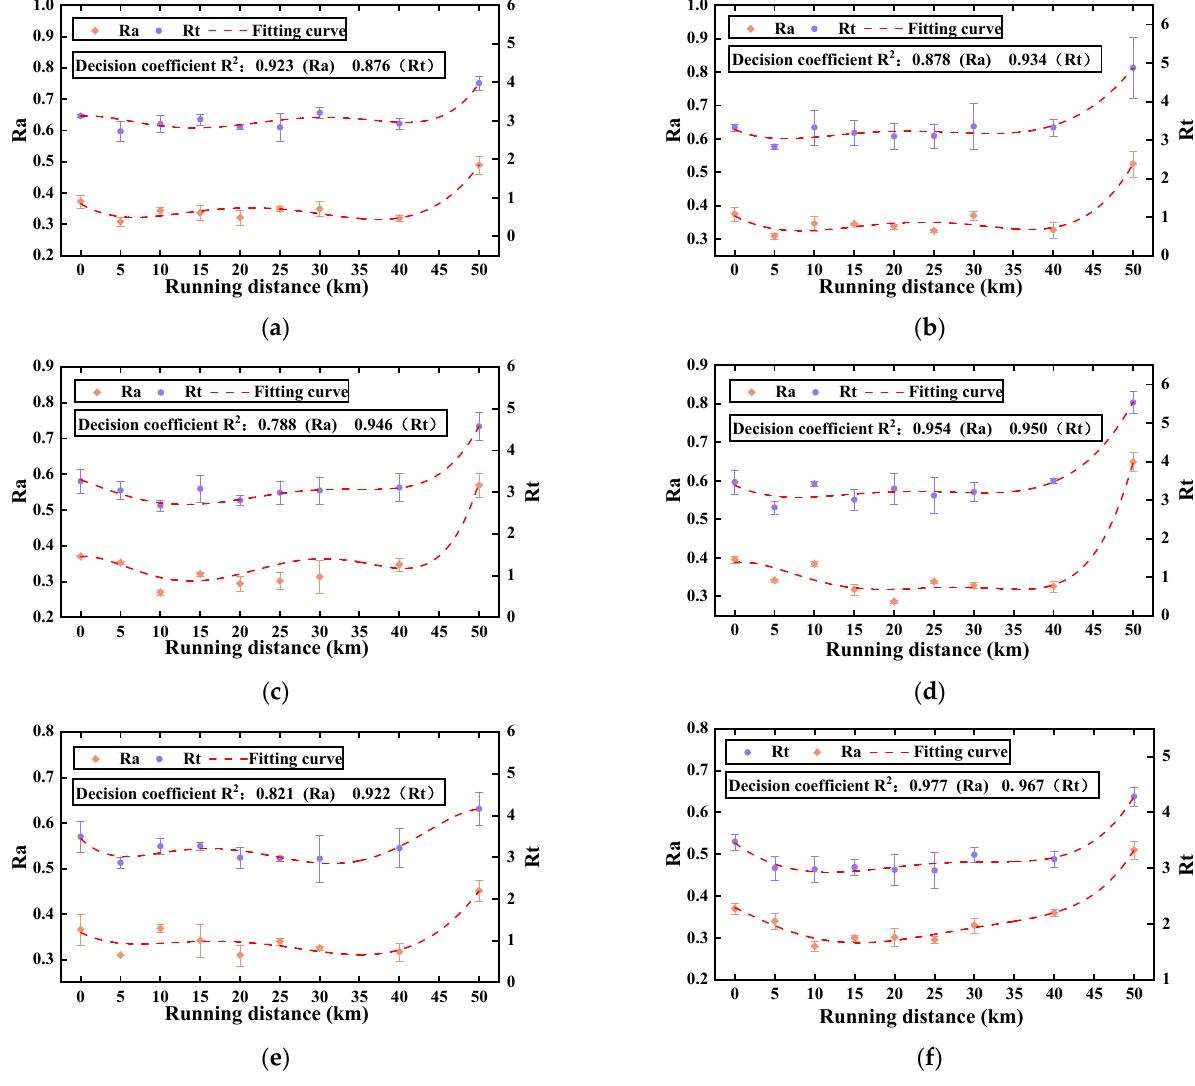
Figure 10. Evolution of the arithmetic mean deviation of the contour and maximum peak-to-valley height of the profile during wear. ( a ) Region 1, ( b ) Region 2, ( c ) Region 3, ( d ) Region 4, ( e ) Region 5 ( f ) Region 6.